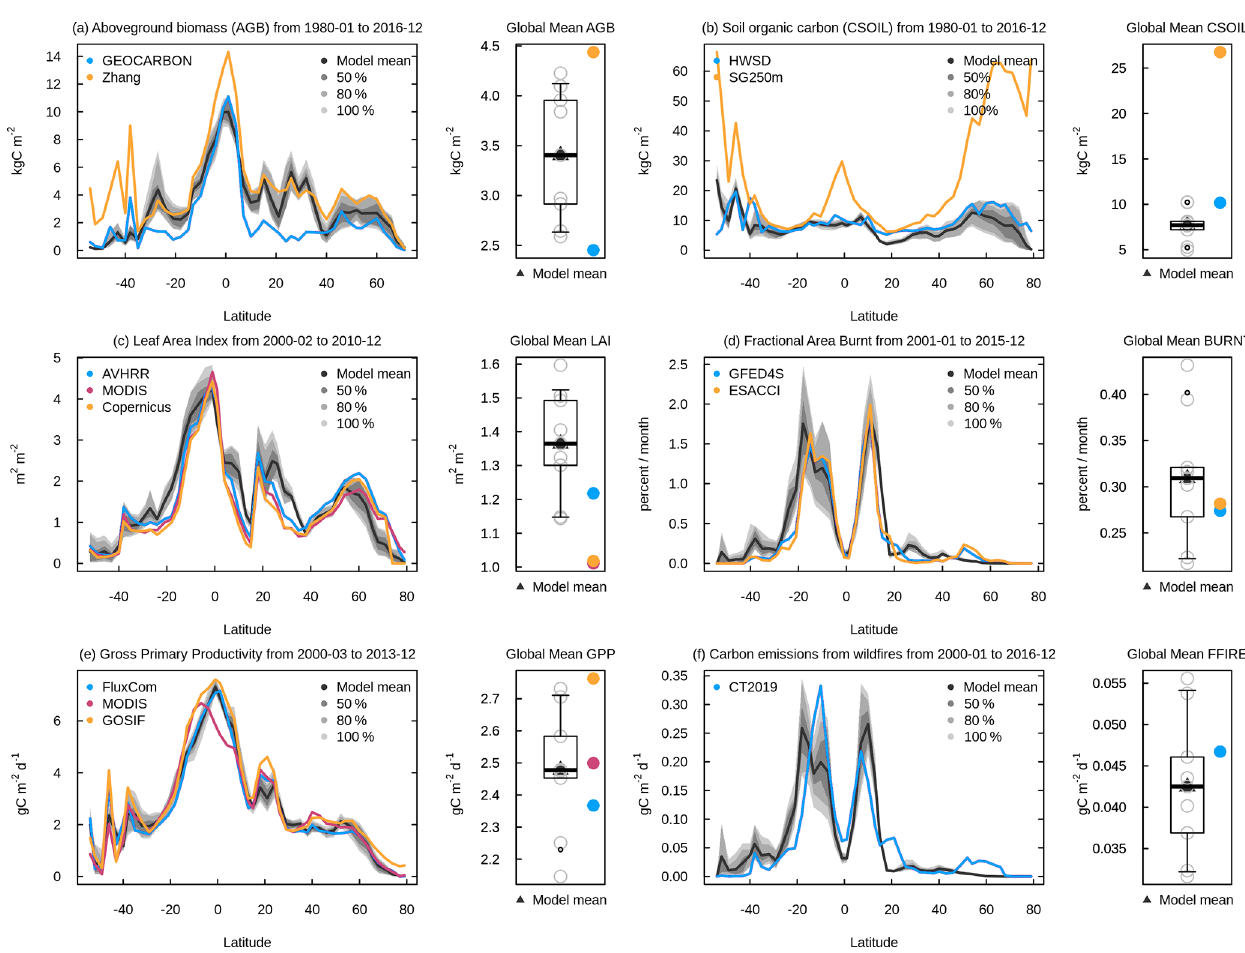
Figure 11. Zonally averaged values of aboveground biomass (a) , soil carbon mass (b) , leaf area index (c) , fractional area burnt (d) , gross primary productivity (e) , and fire CO 2 emissions (f) from the eight simulations summarized in Table 1. The model results are shown as their mean (black) and as the spread across the eight simulations, indicated by 50%, 80%, and 100% ranges in different shades of grey. The observation-based estimates used in AMBER to calculate scores are shown in coloured